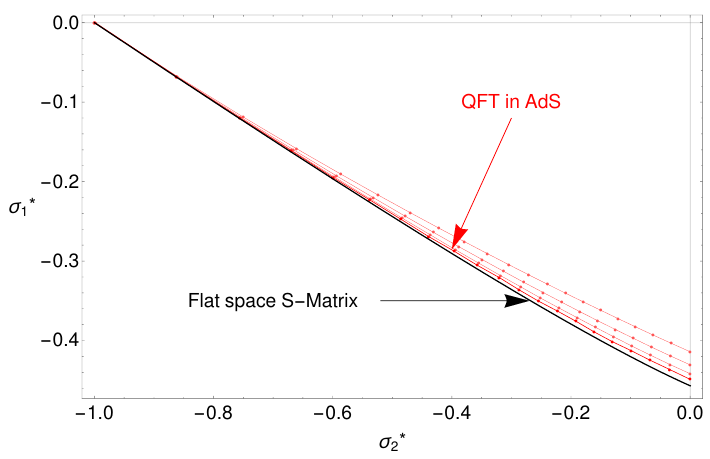
Figure 14 . Bounds on the rescaled variables σ ∗ exterior. The black line, corresponds to the flat space values of the sine gordon kink S-matrix, in the parameter range 1 / 4 ≤ ∆ K = 2 π/β 2 ≤ 1 / 2 , which is the no-bound state range.